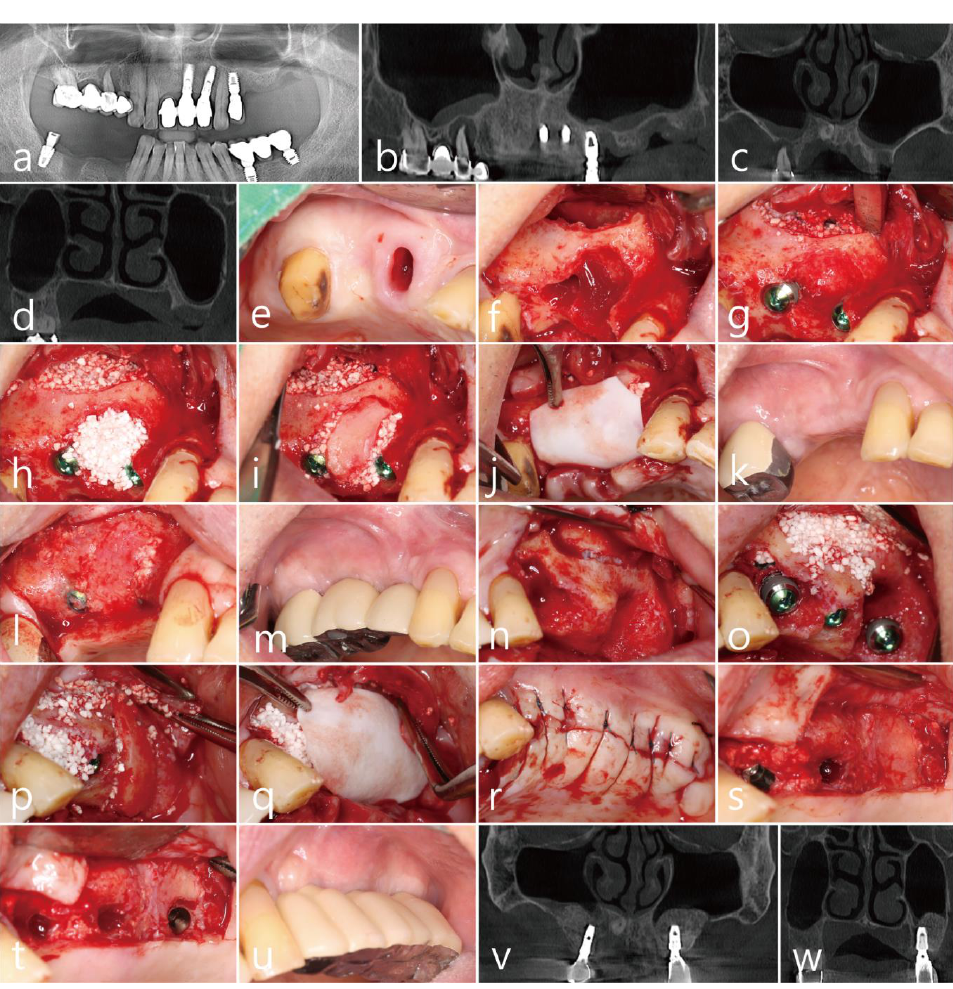
Figure 3. Case 3: ( a ) preoperative panoramic radiograph; ( b ) preoperative panoramic image of the CBCT scan; ( c ) posterior superior alveolar arteries (PSAAs) are shown on the coronal images of the